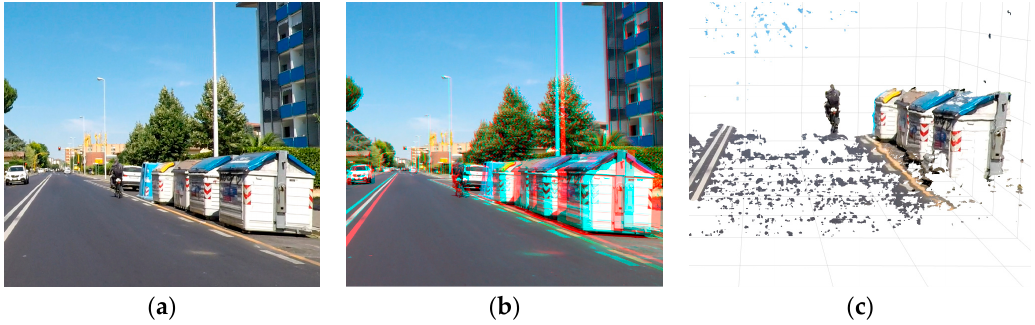
Figure A2. Example of the artificial depth interpretation of a real traffic scene thanks to the stereo camera sensor technology. ( a ) Left image acquired from a stereo camera pair onboard the instrumented scooter; ( b ) Anaglyph of the traffic scene, it can be see the scene in 3D by wearing color-coded glasses (red-blue ones); ( c ) 3D point cloud representation of the scene in which can be detected the location in the space of the cyclist and the garbage bins placed on the right side of the lane.